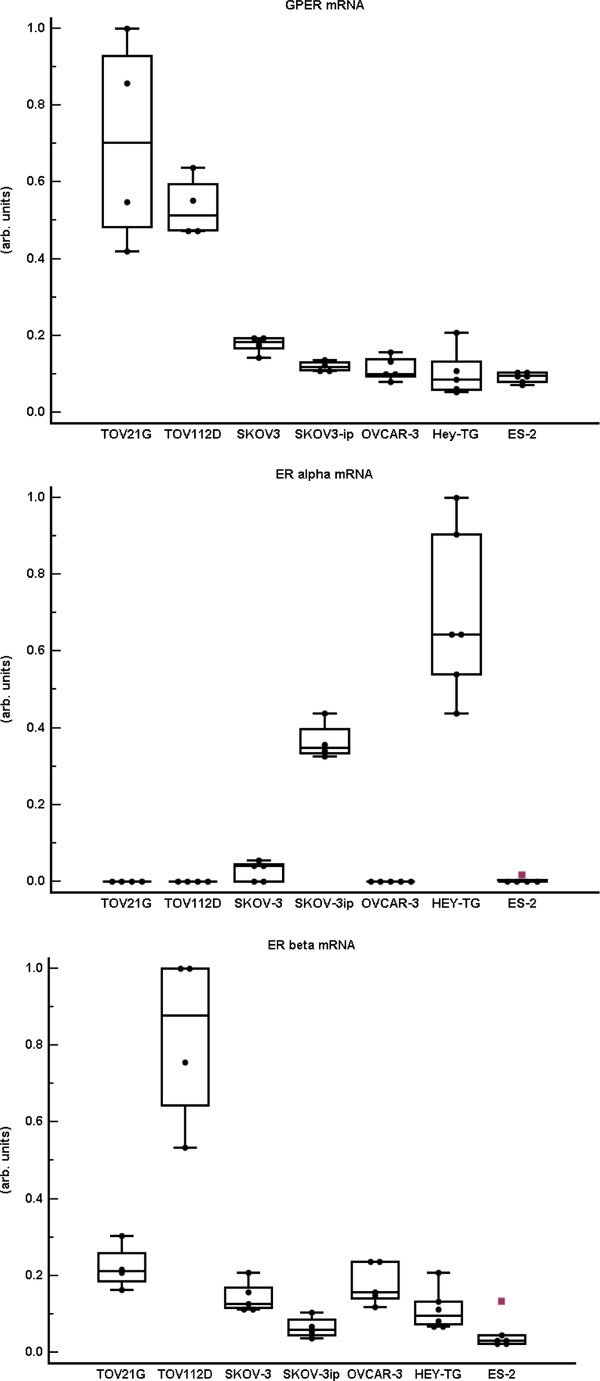
GPER, ERα and ERβ gene expression in ovarian cancer cell lines GPER, ERα, and ERβ mRNAs were normalized to corresponding β-actin mRNA in seven ovarian cancer cell lines (analyzed in 4-6 wells). Cell lines are arranged in order of declining GPER mRNA level. All cell lines expressed GPER mRNA and ERβ mRNA with highest levels in TOV21G and TOV112D. ERα mRNA was not detected in TOV21G, TOV112D, OVCAR3, ES2, and in insignificant amounts in SKOV-3.